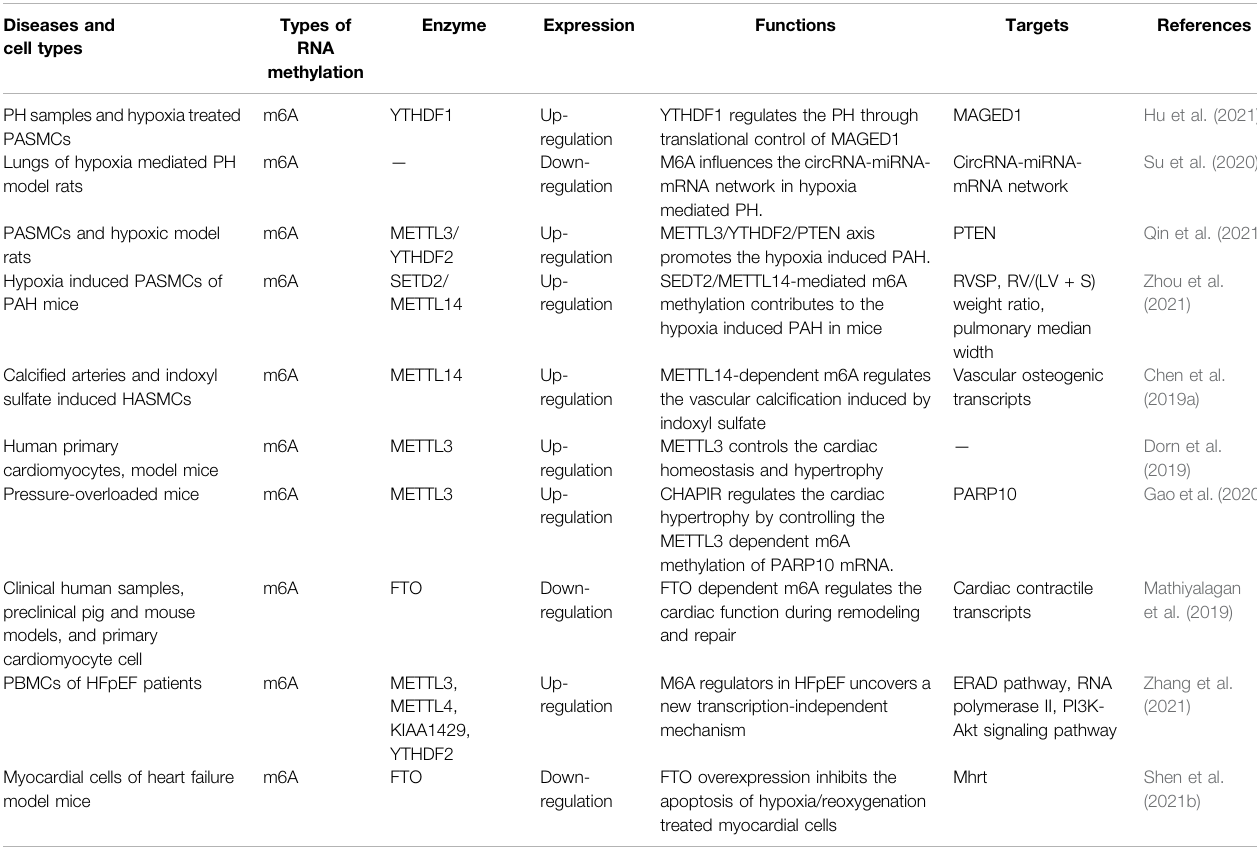
TABLE 1 | RNA methylation related enzymes in